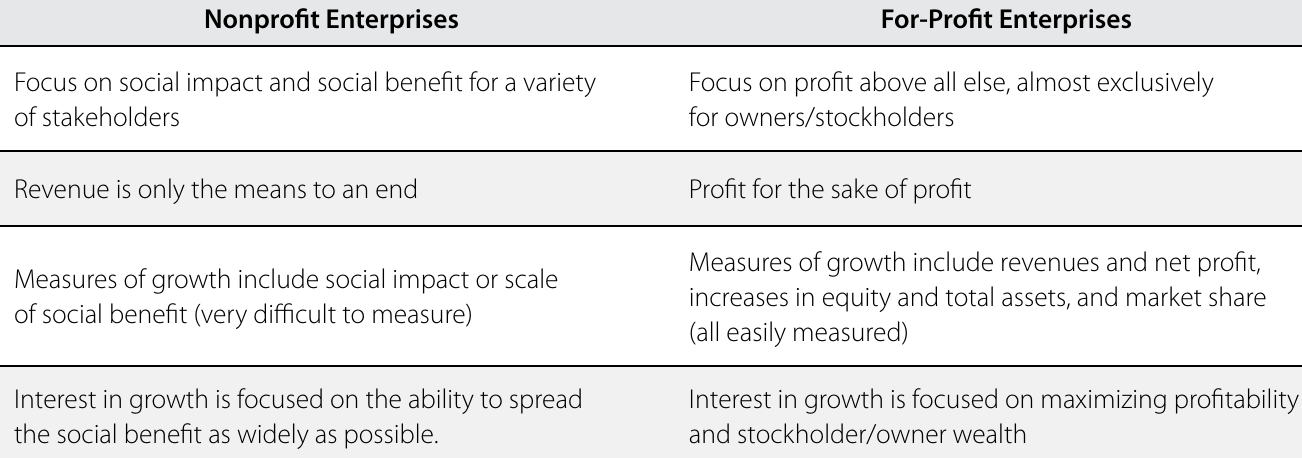
Table 2. Comparing Nonprofit Enterprises and For-Profit